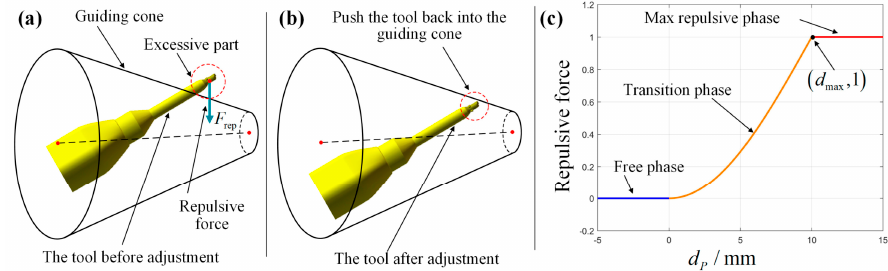
Figure 7. Repulsive force: ( a ) Before adjustment; ( b ) After adjustment; ( c ) Force–distance profile.